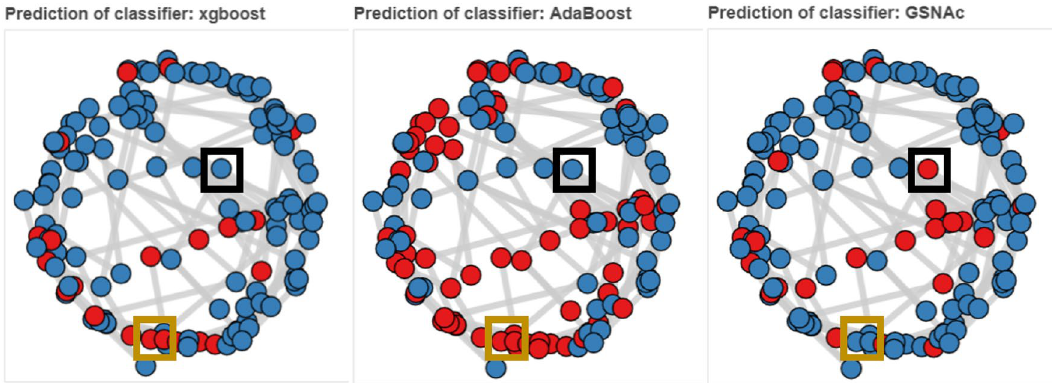
Figure 9. Overall classification result on C. Elegans dataset. Blue color implies that the specific sample has been predicted true by the respective classifier (such as AdaBoost); red color indicates false prediction. Boxes in black indicate cases where the same sample has been predicted true (as in blue colors) by XGBoost and AdaBoost classifiers, but false (as in red colors) by GSNAc, and boxes in orange indicate opposite cases (i.e., false by XGBoost and AdaBoost while true by